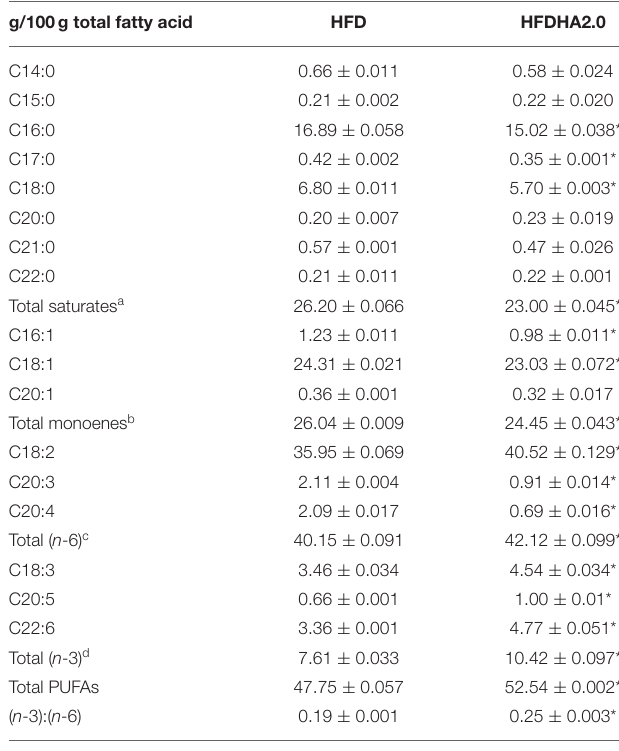
TABLE 3 | Fatty acid composition in the livers of one-month-old zebrafish fed with HFD or HFDHA2.0 for 4 weeks. g/100g total fatty acid